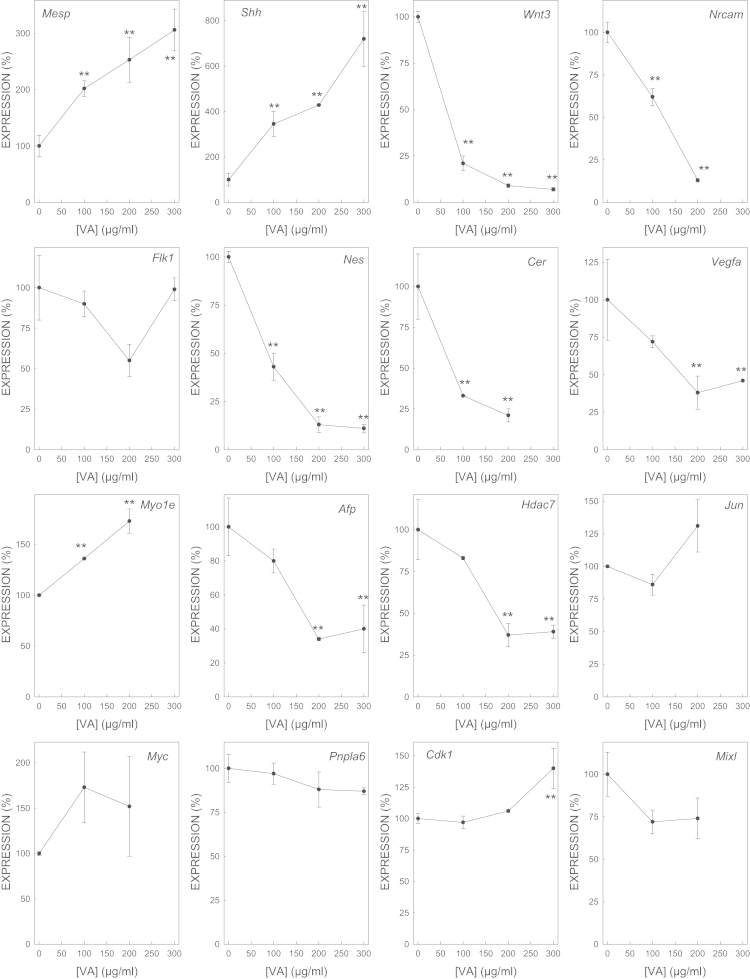
Effect of VA on the expression of biomarker genes.